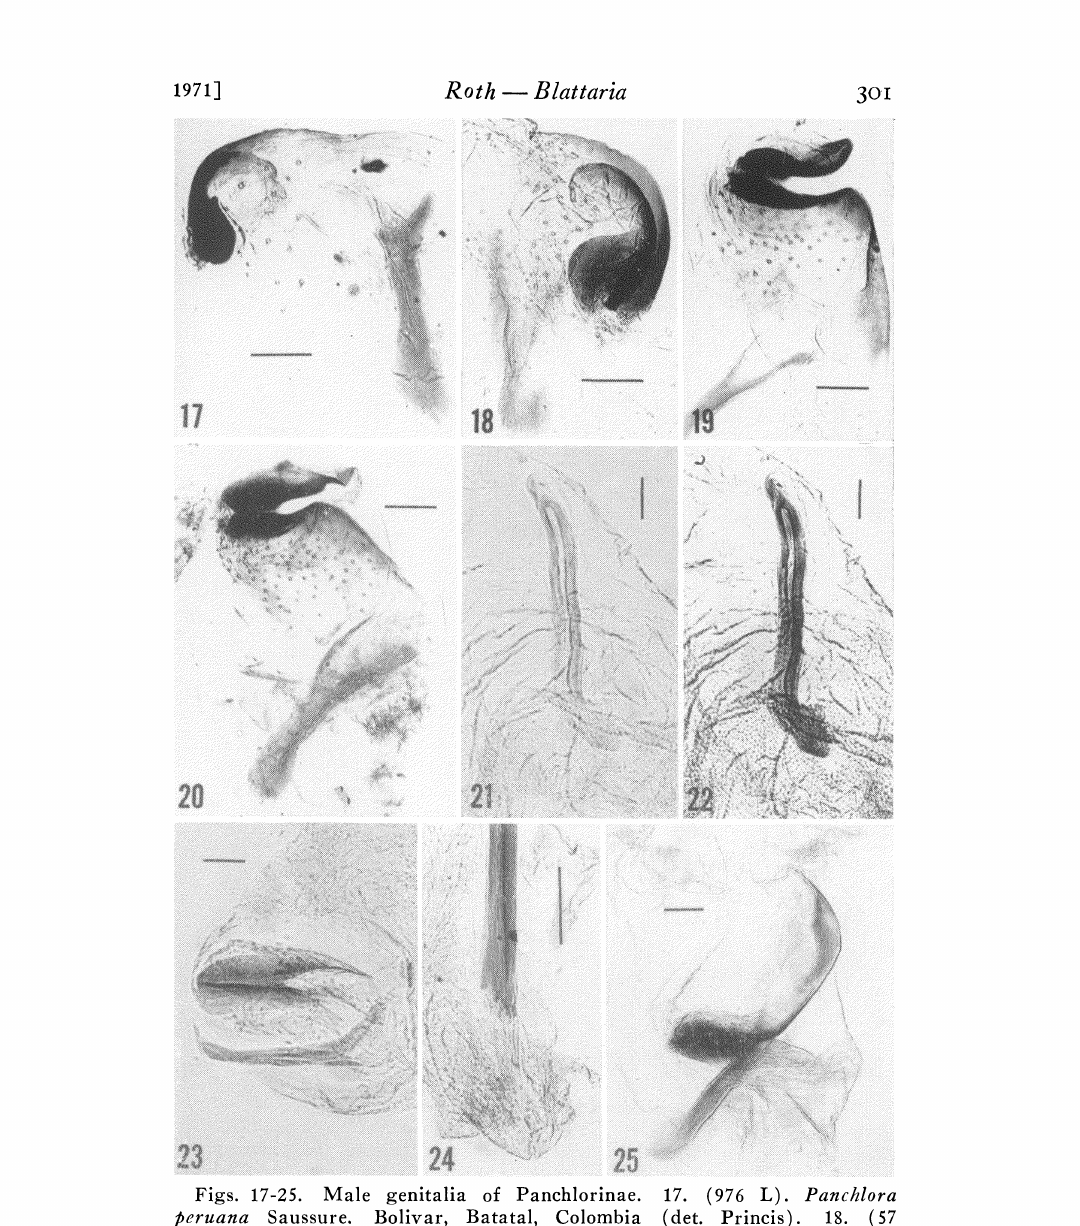
Figs. 17-25. Male genitalia of Panehlorinae. 17. (976 L). Panchlora peruana Saussure. Bolivar, Batatal, Colombia (det. Prineis). 18. (57 CUZM). Panchlora minor Saussure and Zehntner. Brazil (det. Prineis). 19. (973 L). Panchlora sagax Rehn and Hebard. St. Thomas, Lesser An- tilles (det. Prineis). 20. (975 L). Panchlora dumicola Albuquerque and Gurney. Brazil (det. Prineis). 21-23. (174 USNM). Biolleya alaris Saus- sure. Paratype. La Palma, Costa Riea. (Figs. 21 and 22 are the same L2vm taken with Polaroid Type 51 and 52 film respectively). 24-25. Achro- blatta luteola (Blanehard). Darien Province, San.te Fe, Panama (det. Fisk). (scale 0.1